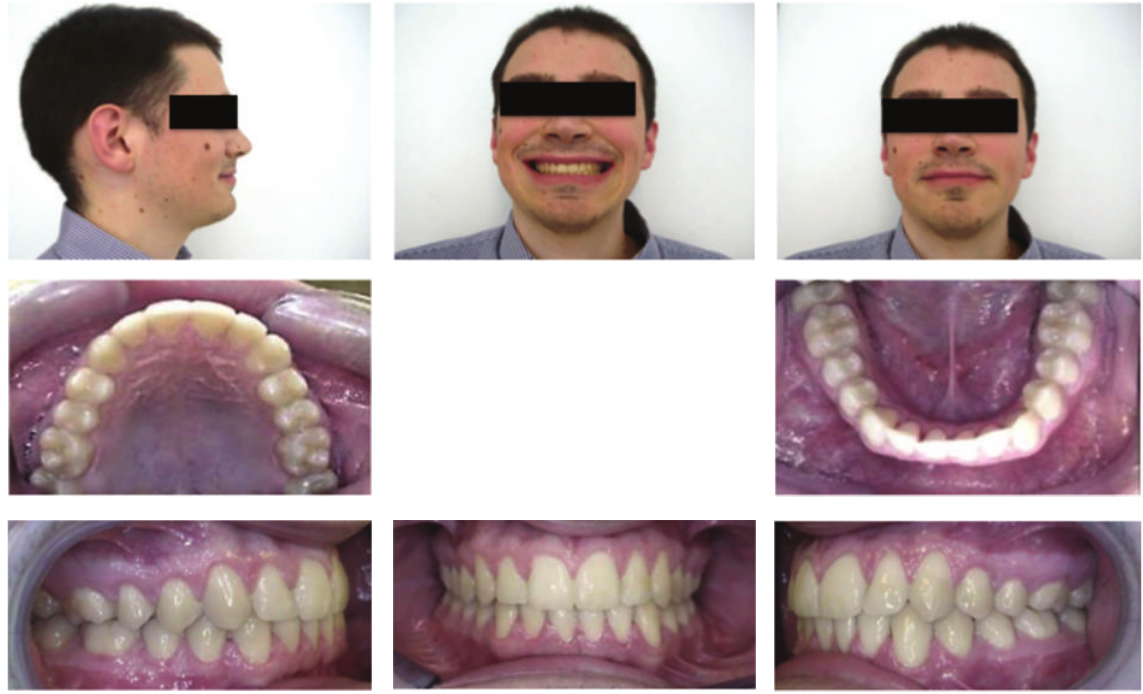
Figure 13: Clinical pictures of the patient at the 6-year follow-up recall